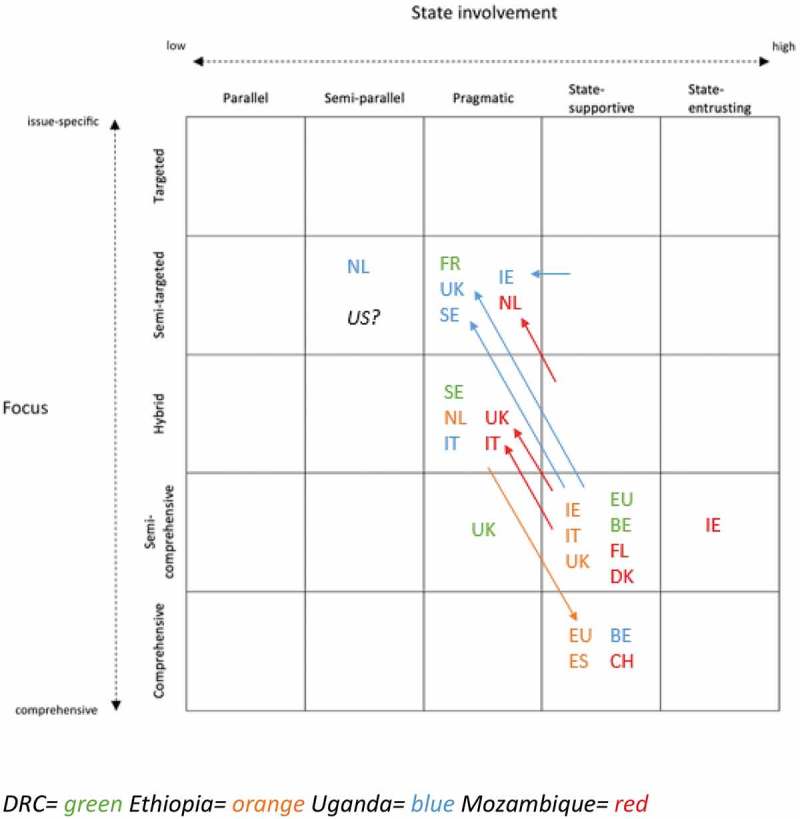
Summary framework.